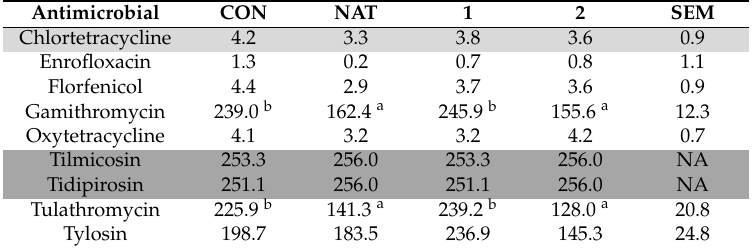
NAT = without antimicrobials; y NA, not applicable as arithmetic